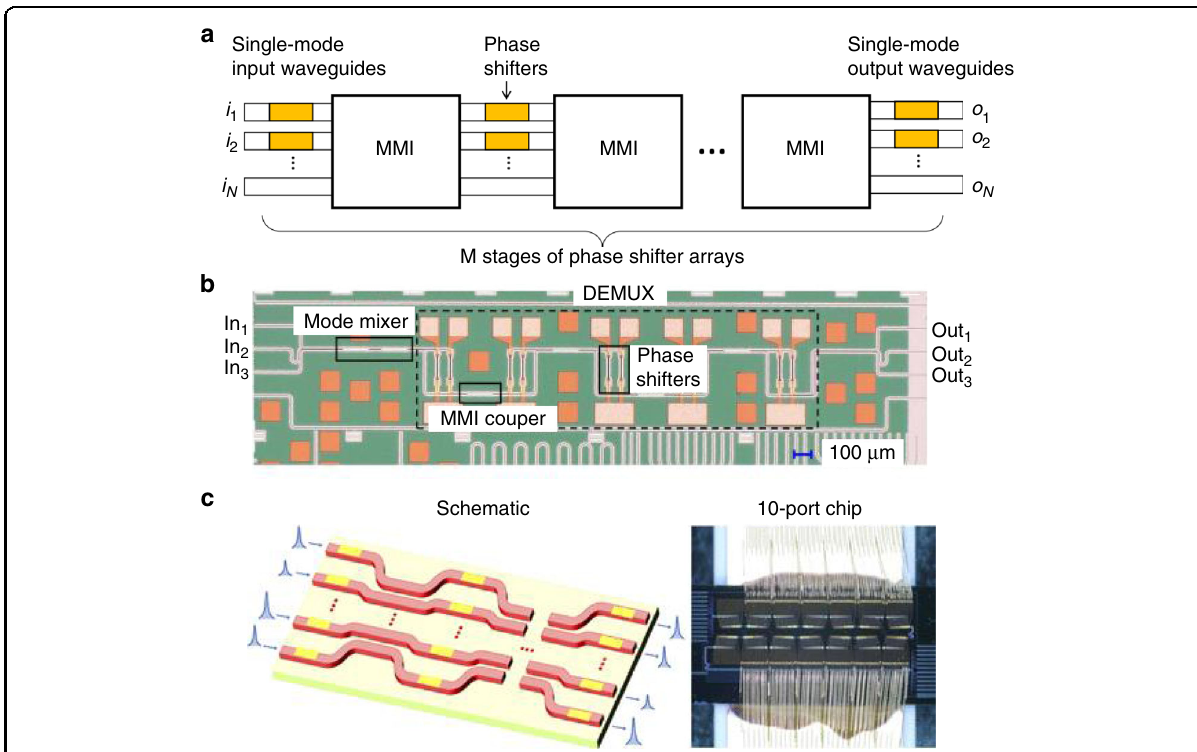
Fig. 5 Integrated MPLC-MVMs. a Schematic diagram 59 . b Three-channel MIMO demultiplexing chip 60 . c Ten-port unitary optical processor 62 . a Reprinted from ref. 59 with the permission of IEEE Publishing. b Reprinted with permission from ref. 60 © The Optical Society. c Reproduced from ref. 62 with permission of ACS